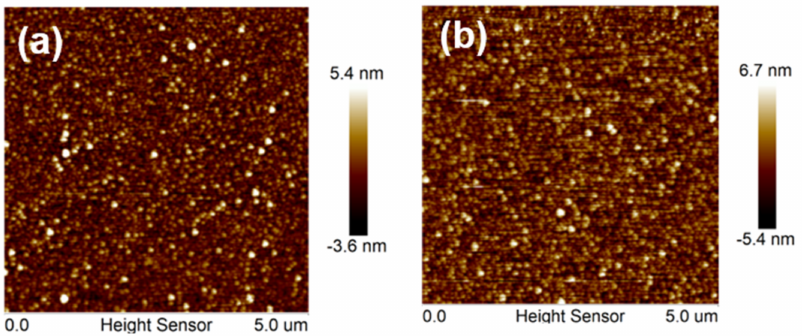
Figure 6. Dry etching rate map of the film using ( a ) C 3 H 6 and ( b ) C 2 H 2 at 400 ◦